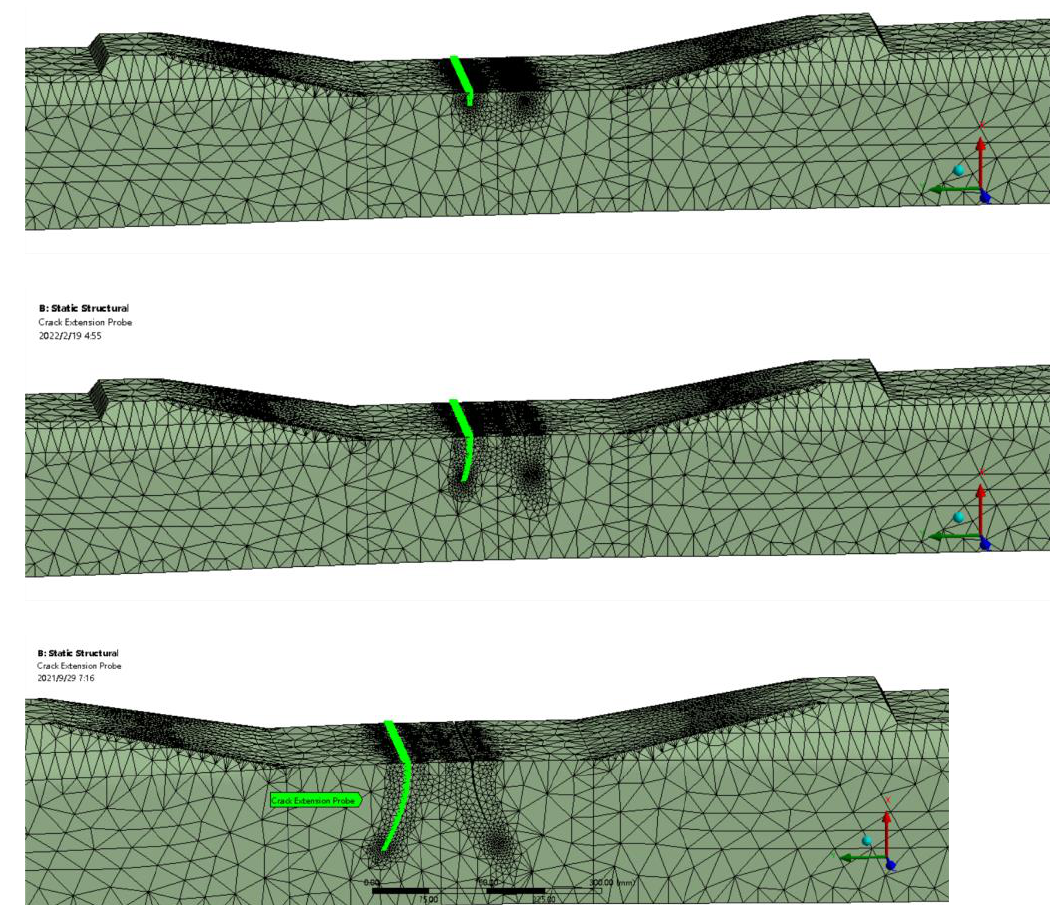
Figure 5. Simulation of crack propagation in the sleeper model at midspan.